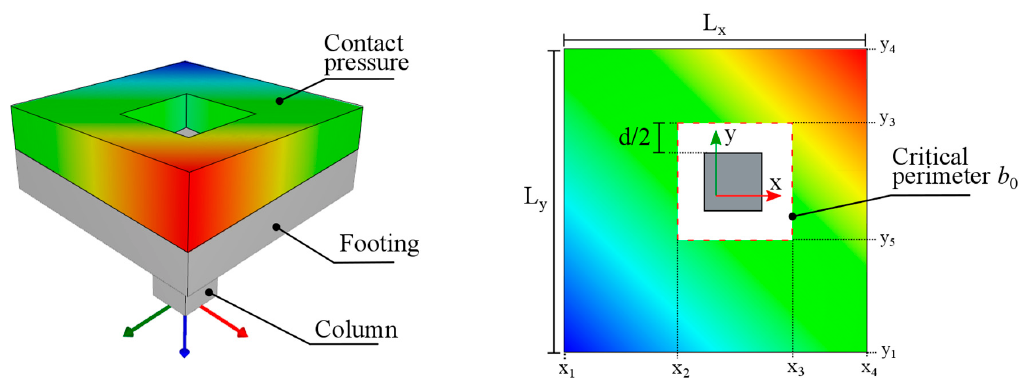
Figure 6. Critical zone consideration for two-way or punching shear.